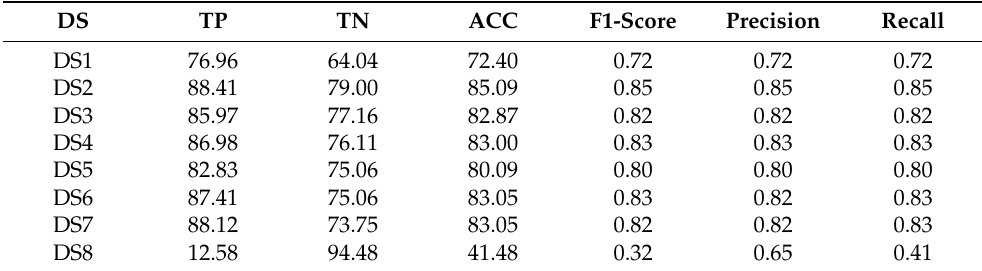
Table 5. Predicting success in the final exams versus retaking exams.